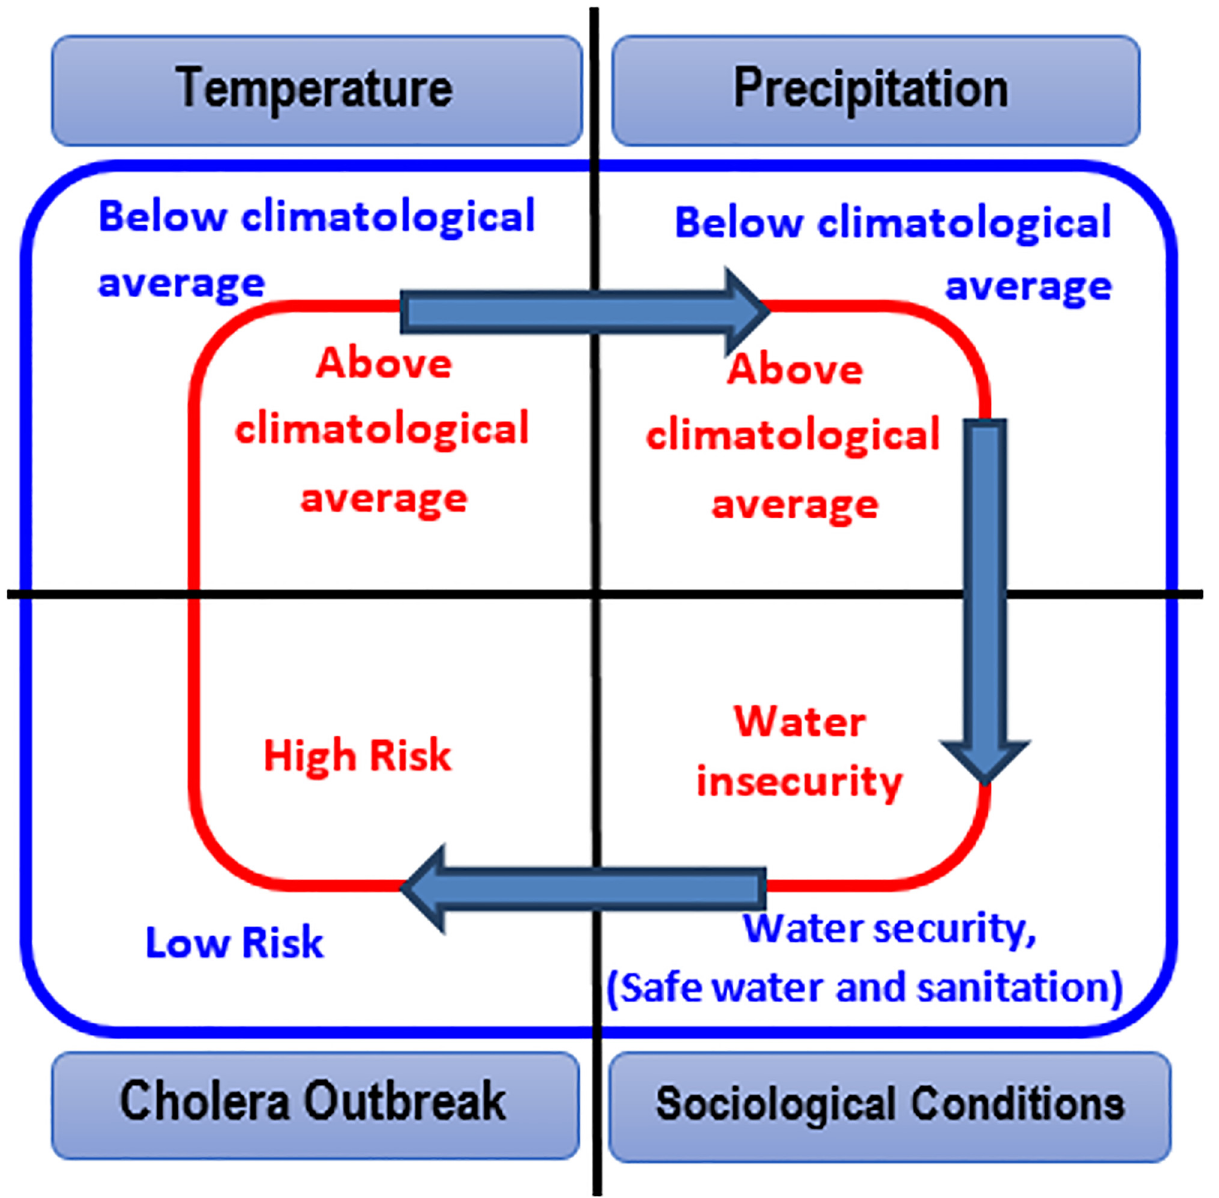
Fig 1. Theoretical hypothesis linking hydroclimatic conditions with sociological aspects and epidemic